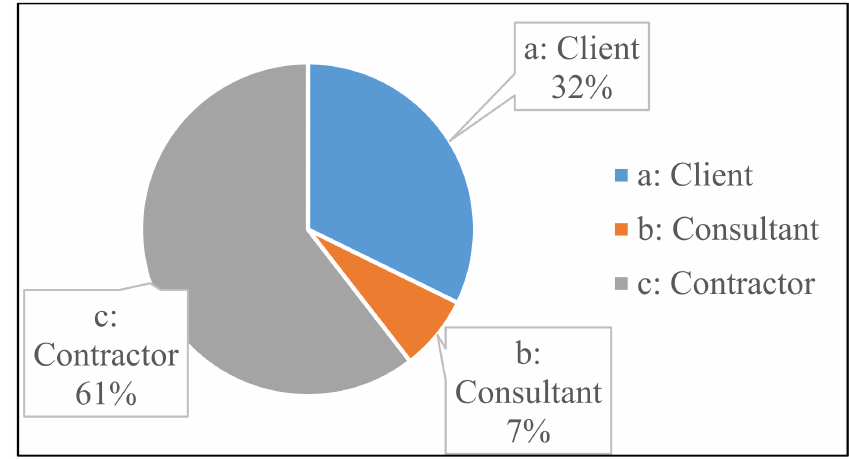
Figure 1. Respondent’s